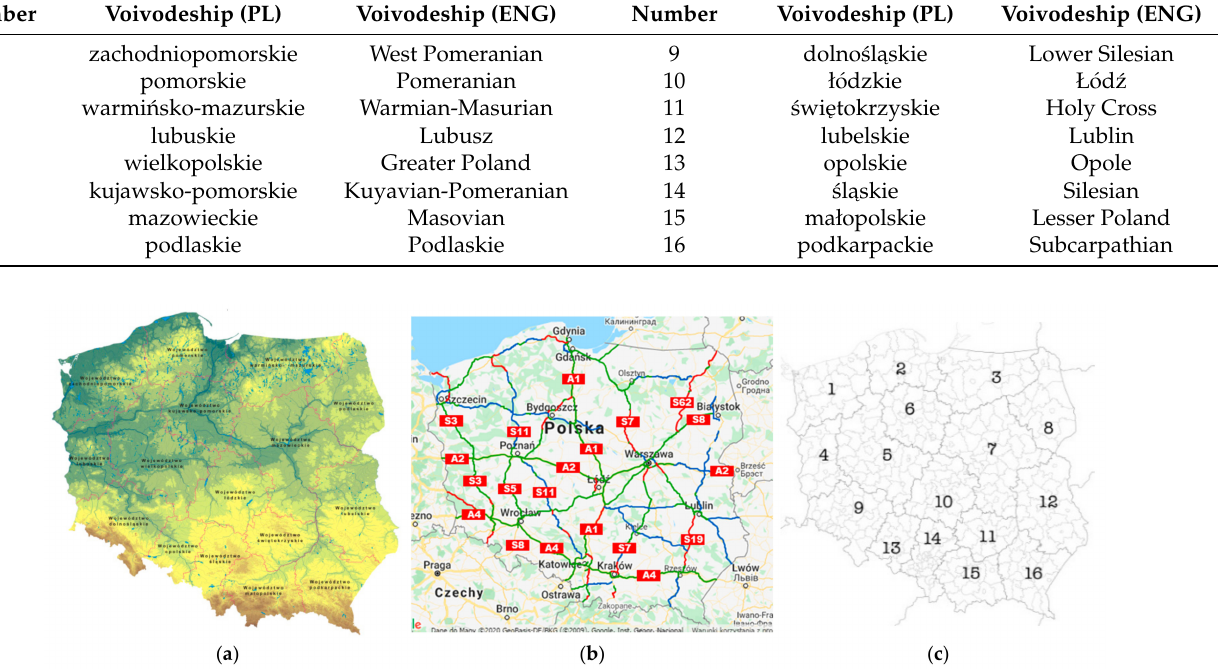
Table 1. List of voivodeships and numbers assigned to them in the publication.